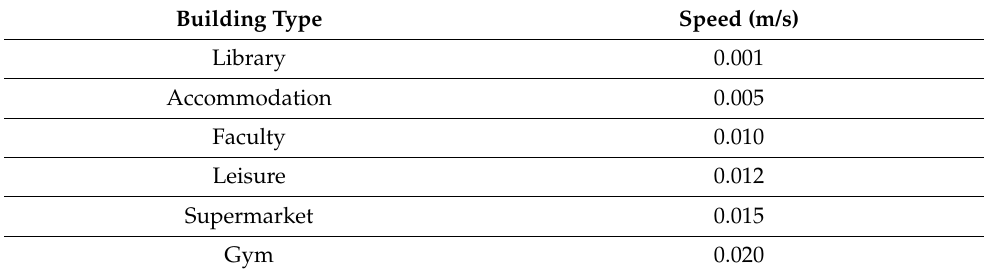
Table 1. Estimated speed values of student and dynamic agents when inside buildings .